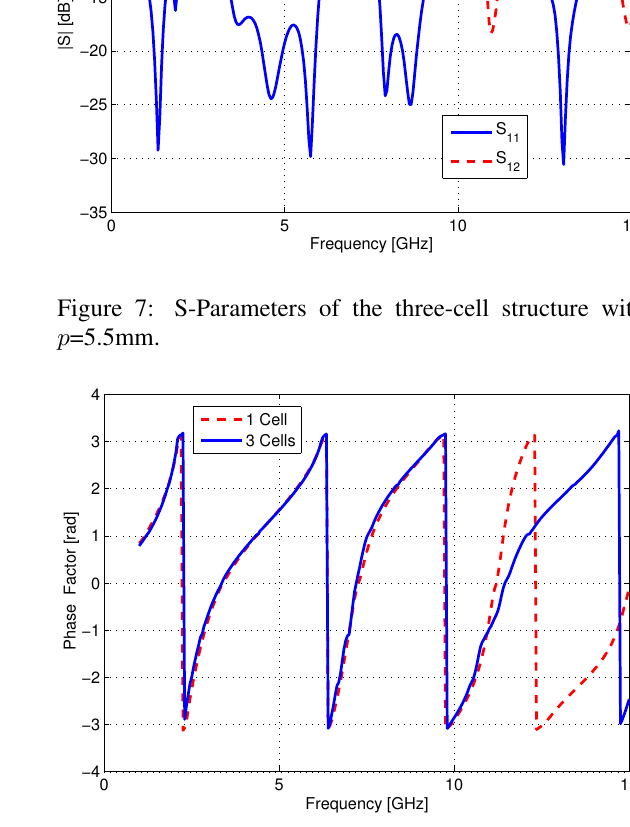
Figure 8: Phase factor of the unit-cell compared to the phase response of the three-cell structure (divided by three), for p = 5 . 5